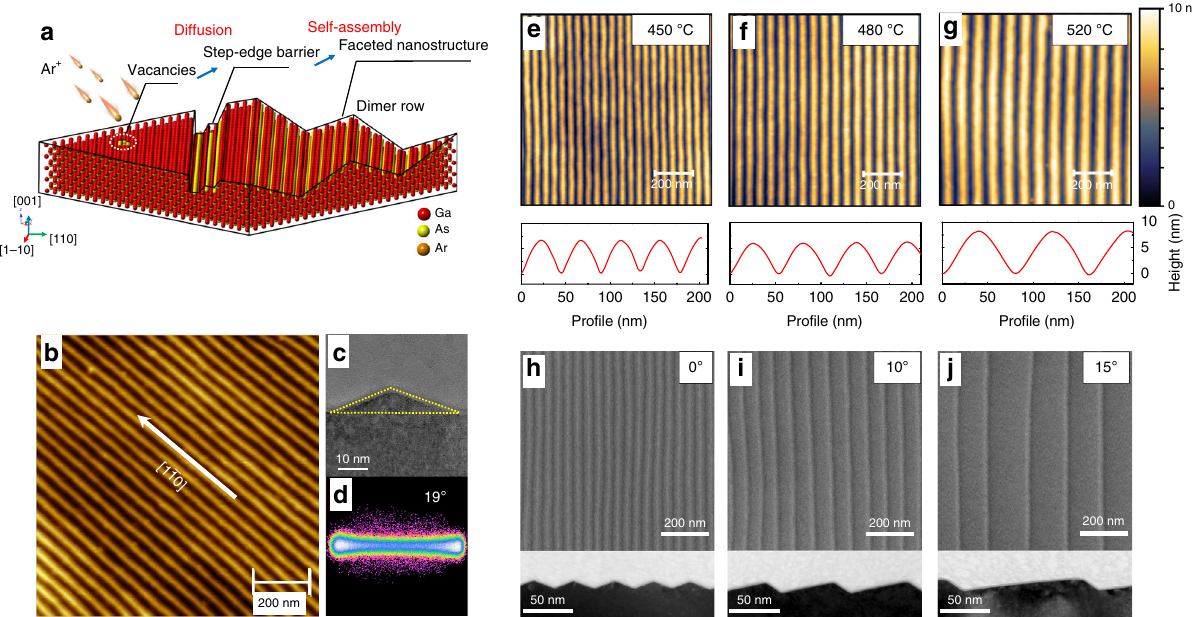
Fig. 1 Fabrication of the nanograting substrates. a Schematic of the vacancy epitaxy on GaAs(001) surfaces. b , c AFM and XTEM images of the sawtooth GaAs substrate with a nanogroove density over 20,000 lines mm − 1 and ( d ) distribution of the facet angles over the AFM image, mostly 19°. e – g AFM images of the GaAs (001) substrates and their cross-section pro fi les along the [110] direction irradiated at 450 °C, 480 °C, and 520 °C. The periodicities of the nanogratings are 48 nm ( e ), 55 nm ( f ), and 78 nm ( g ), respectively. h – j SEM and XTEM images of the nanogroove structures formed on GaAs (001) with a miscut angle of 0°, 10°, and 15° toward the [110] direction. The periodicities of the nanogratings are 48 nm ( h ), 55 nm ( i ), and 155 nm ( j ), respectively